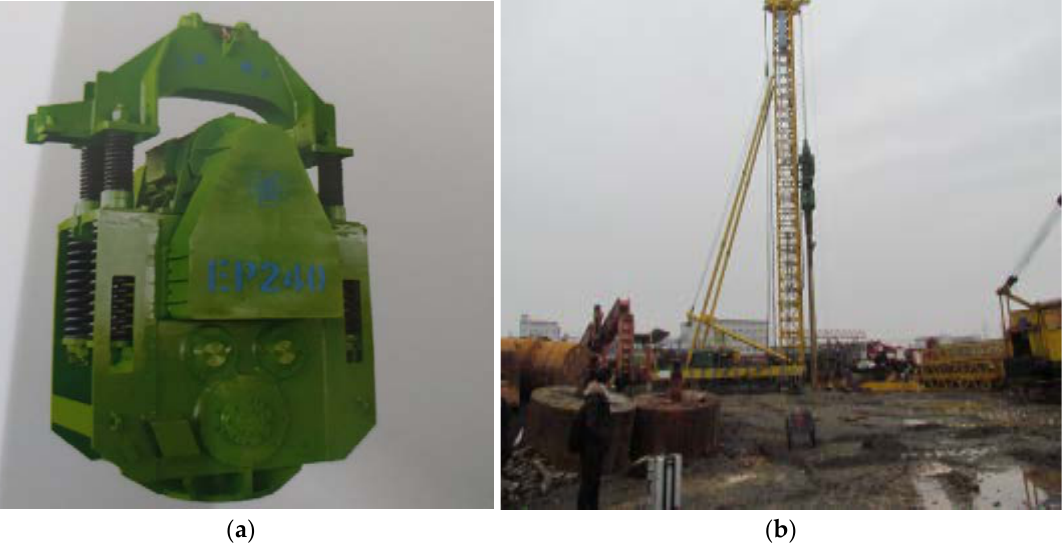
Figure 1. Resonance-free vibratory hammer and dynamic compaction construction: ( a ) Resonance- free vibratory hammer. ( b ) Testing site.